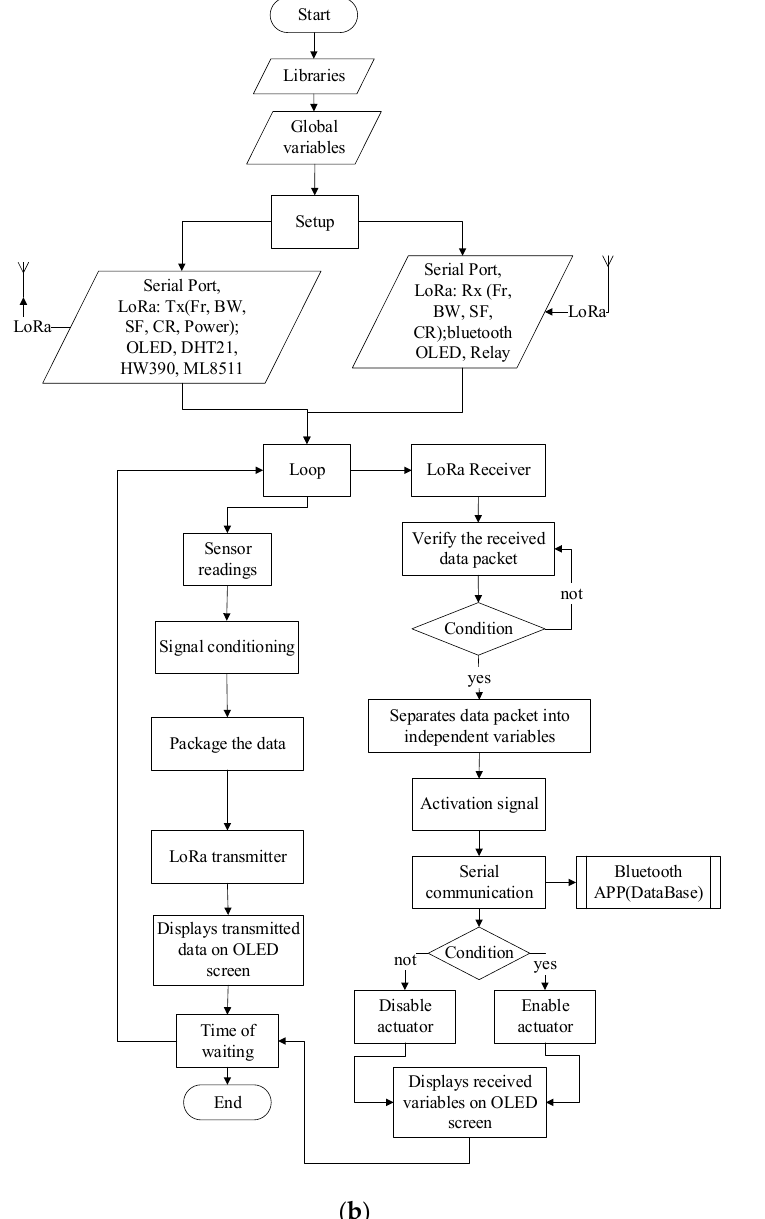
Figure 9. ( a ) Flowchart of the optimized gateway algorithm and ( b ) Flowchart of the optimized end-node algorithm.